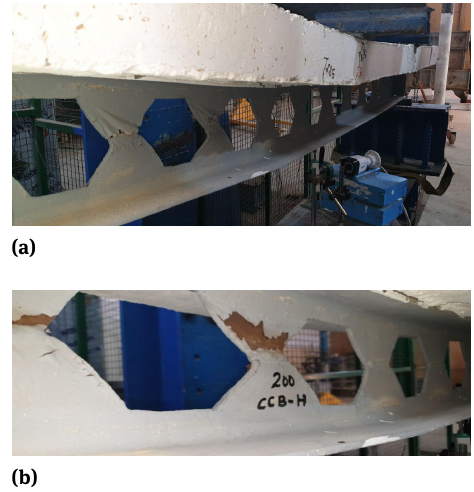
Figure 14: Failure mode of Specimen